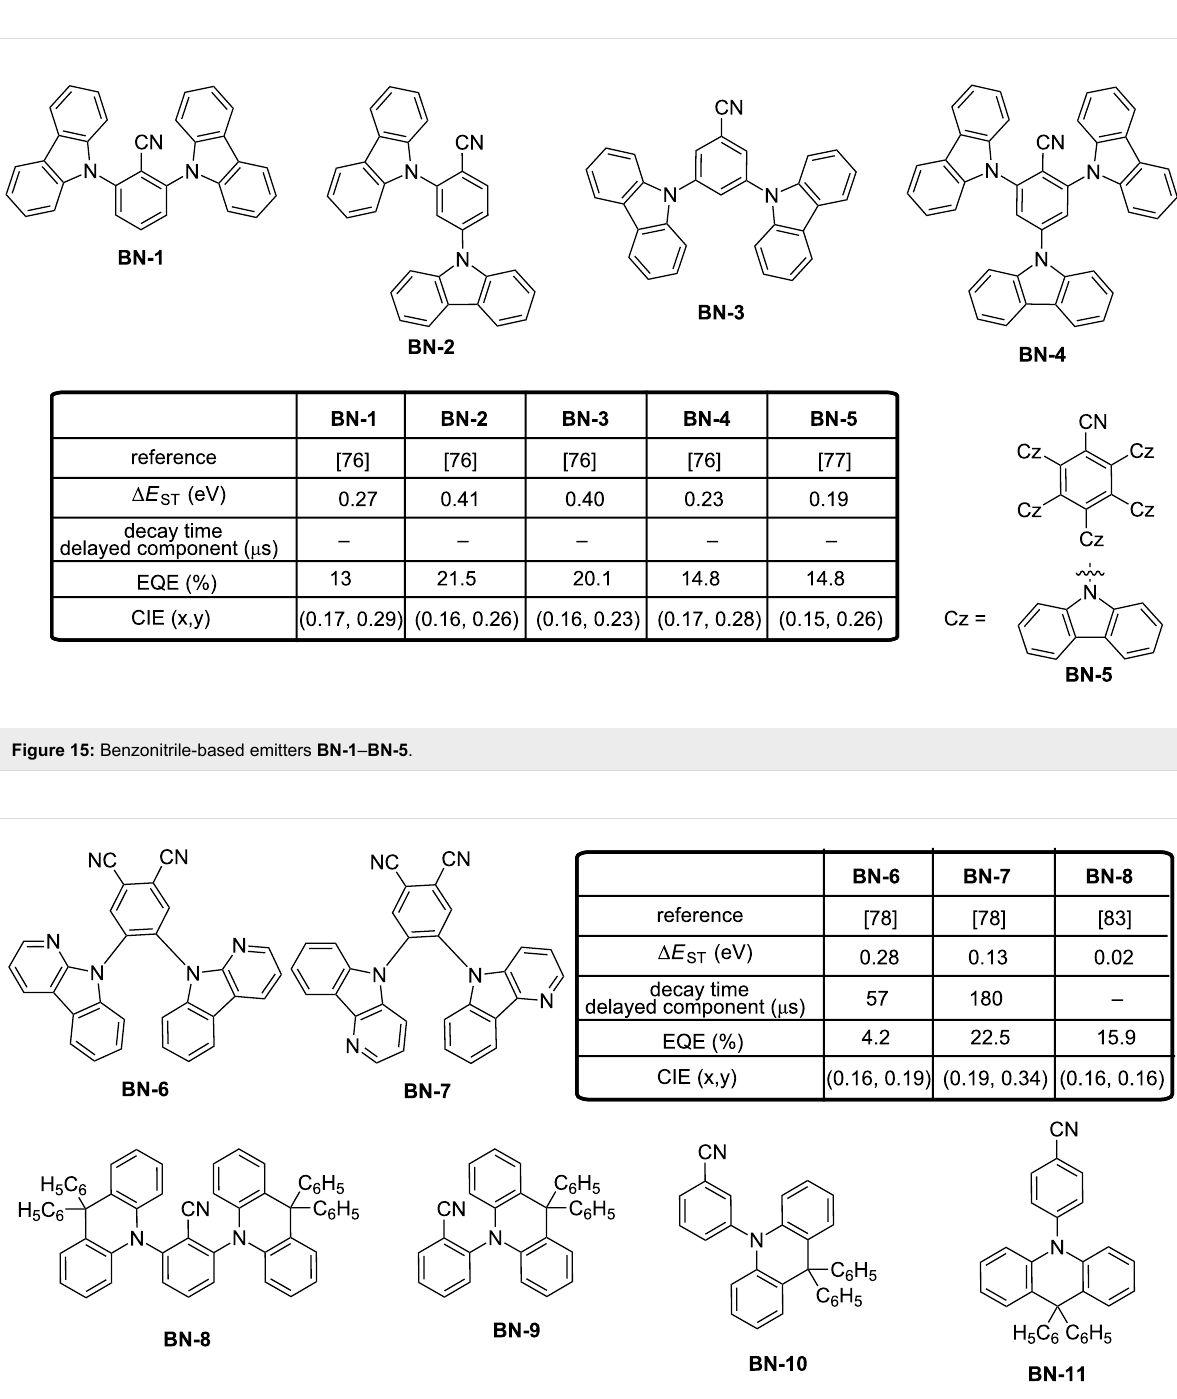
Figure 16: Benzonitrile-based emitters BN-6 – BN-11 .